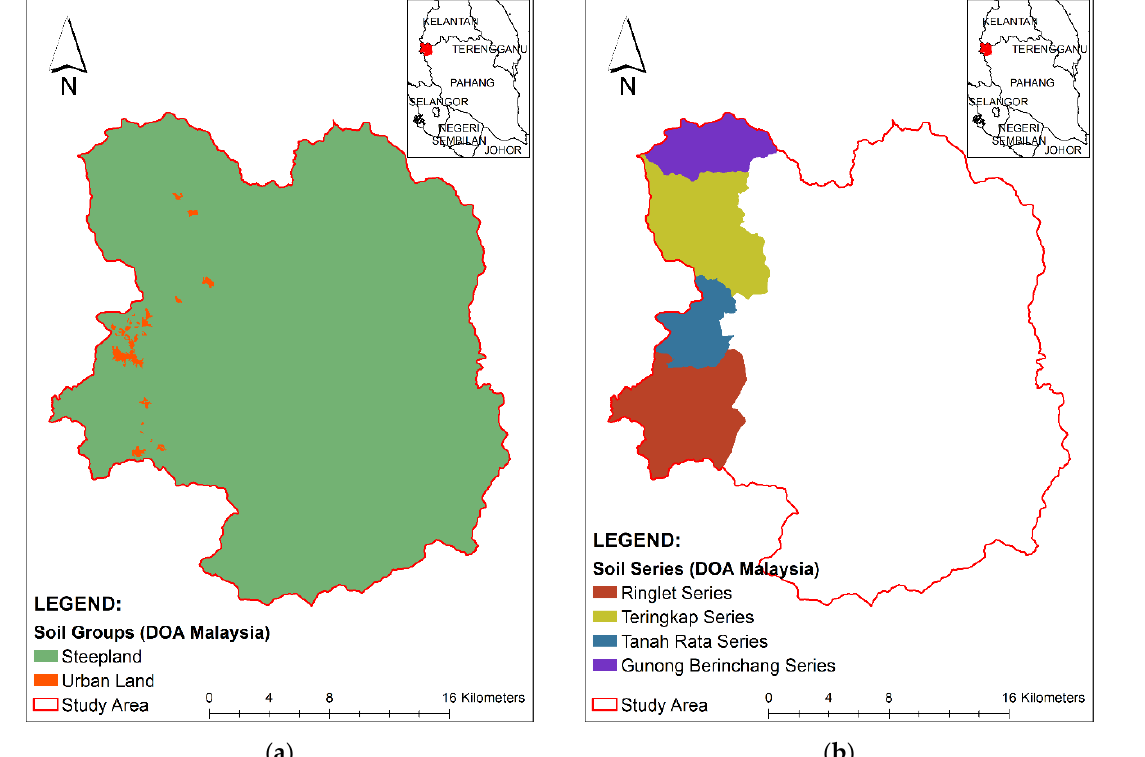
Figure 4. Map of ( a ) major land uses and ( b ) edited soil series in Cameron Highlands [23,25,26].